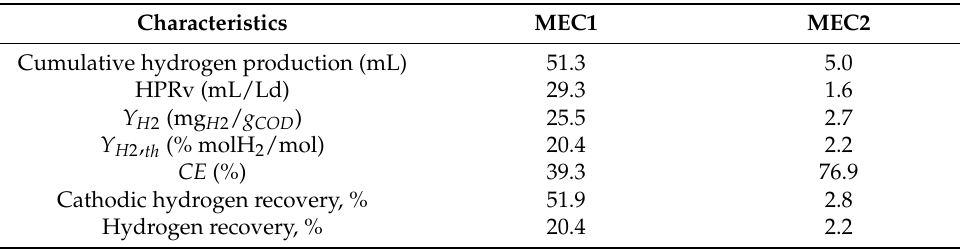
Table 3. The main characteristics of both MECs for the DF effluent feed.